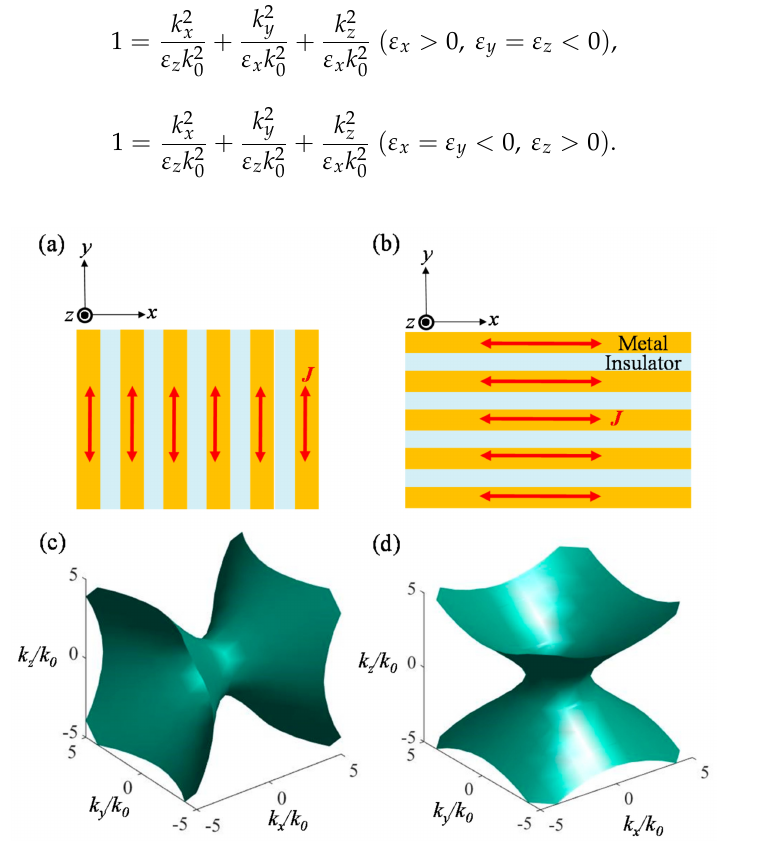
Figure 8. Schemes of basic HMM types whose optic axes are lying in: ( a ) horizontal ( x -direction); and ( b ) perpendicular ( y -direction) directions; ( c , d ) refer to isofrequency dispersion surfaces in the normalized momentum space for HMMs with ( a , b ) structures. Analytic expressions of plots in ( c , d ) are Equations (3) and